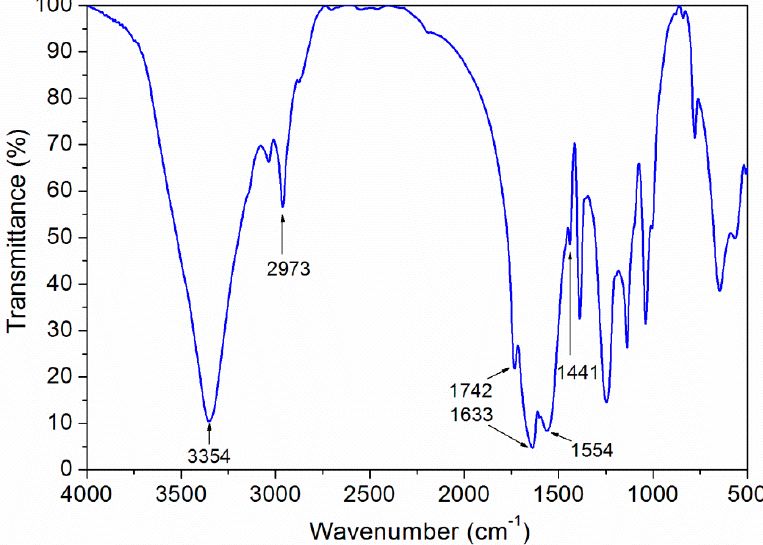
Figure 3. FTIR of urea-formaldehyde (UF) with waterborne emulsion microcapsules.